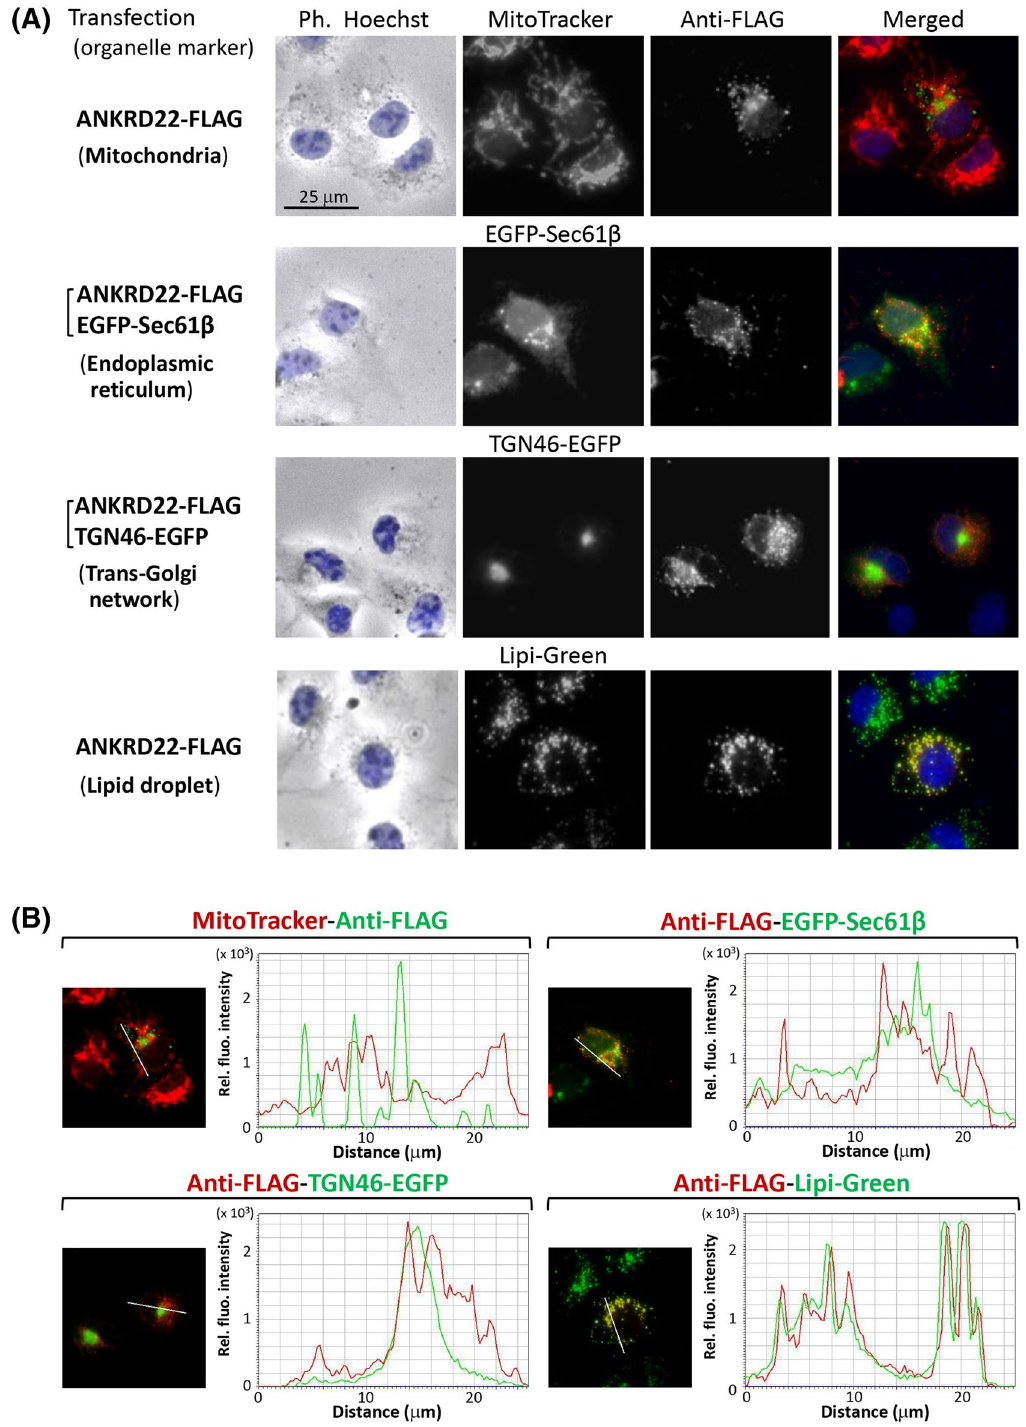
Figure 2. Analysis of the intracellular localization of ANKRD22. Intracellular localization of ANKRD22 was assessed by immunofluorescence analysis of COS-1 cells transfected with cDNA coding ANKRD22-FLAG using anti-FLAG antibody. Hoechst, MitoTracker Red, EGFP-Sec61β, TGN46-EGFP, and Lipi-Green were used as organelle markers for nucleus, mitochondria, ER, trans-Golgi network, and LD, respectively. The experiments were repeated 3 times and the similar results were obtained. A representative data was presented. ( A ) Phase contrast and fluorescence images obtained by immunofluorescence analysis. ( B ) The results of the line profile analysis of the fluorescence images obtained in ( A ). For this analysis, corresponding line-scan graphs of the relative fluorescence intensities of green fluorescence (green line) and red fluorescence (red line) along the white line indicated in the merged images are